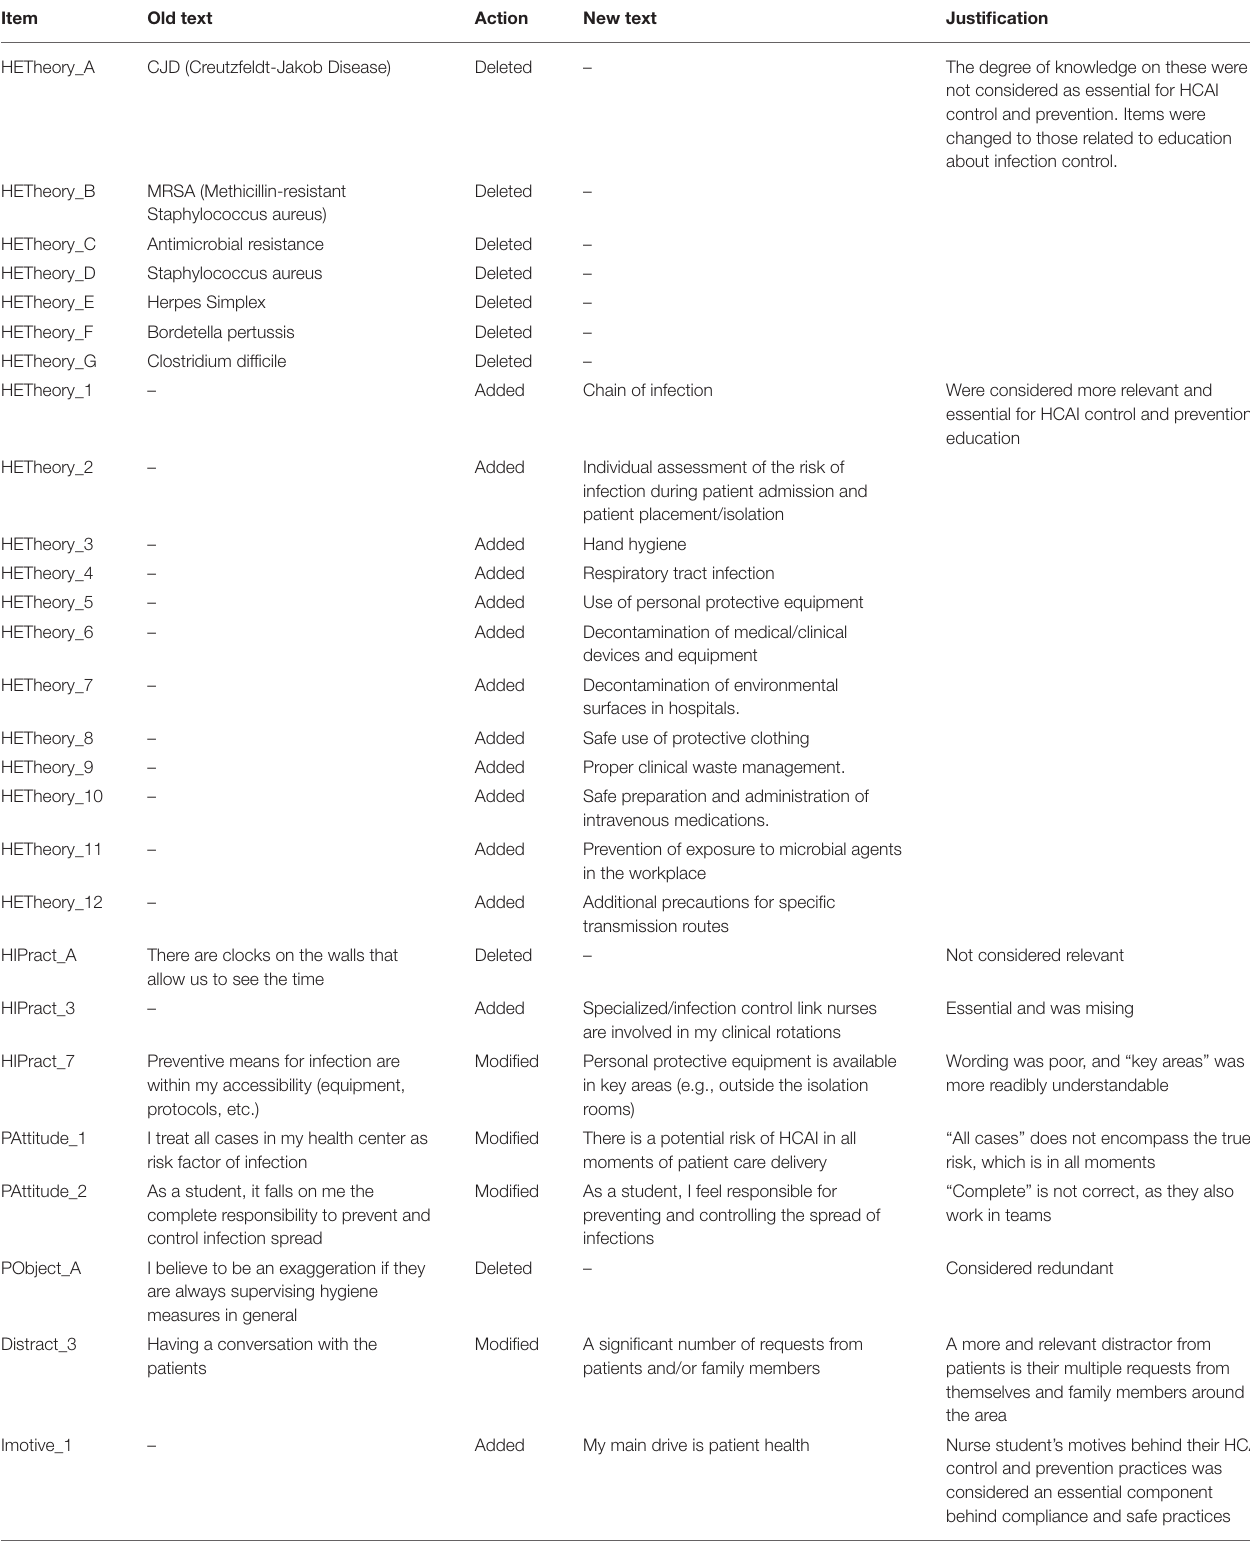
TABLE 2 | Description and justification of original item modifications during their generation